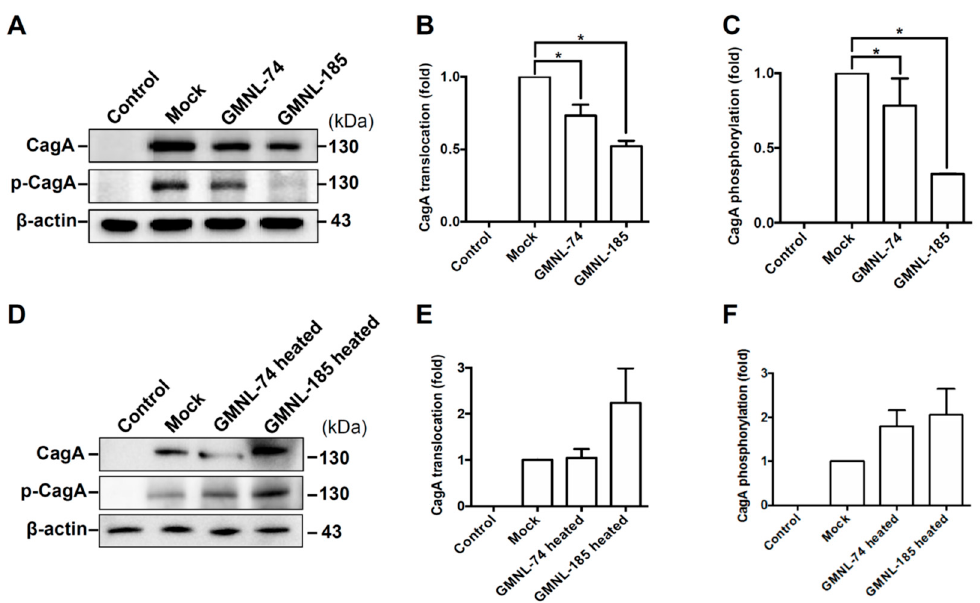
Figure 3. Lactobacillus spp. reduced H. pylori CagA translocation and phosphorylation. AGS cells were treated with live or heat-inactivated Lactobacillus spp. (GMNL-74 and GMNL-185) prior to infection by H. pylori 26695 at multiplicity of infection (MOI) 100 for 6 h. ( A , D ) Samples were subjected to Western blot analysis. The levels of ( B , E ) CagA translocation and ( C , F ) CagA phosphorylation were determined by densitometric analysis. Each experiment result shows the mean ± standard deviation of three independent experiments. *, p < 0.01.